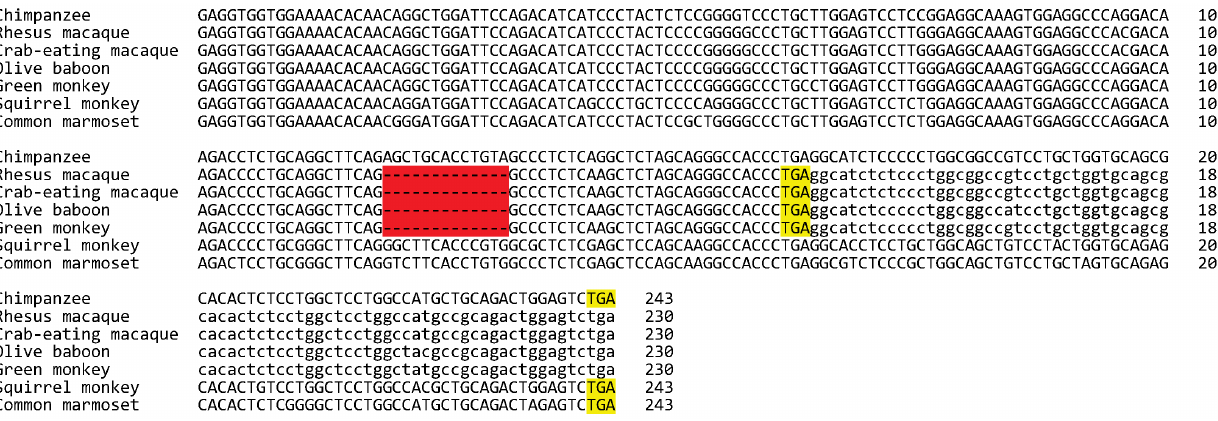
Figure 3. A 13-nt deletion in Old World cercopithecine monkey MOXD2 exon 13. The MOXD2 exon 13 sequences from the chimpanzee ( Pan troglodytes ), the rhesus macaque ( Macaca mulatta ), the crab-eating macaque ( Macaca fascicularis ), the olive baboon ( Papio anubis ), the green monkey ( Chlorocebus sabaeus ), the squirrel monkey ( Saimiri boliviensis ), and the common marmoset ( Callithrix jacchus ) were subjected to multiple alignment. The 13-nt deletion, which was common to the four cercopithecine monkeys, is highlighted in red. Stop codons are highlighted in yellow. Note the premature stop codons present in the cercopithecine monkey MOXD2 genes caused by a frameshift deletion. Uppercase and lowercase letters indicate coding and noncoding sequences,